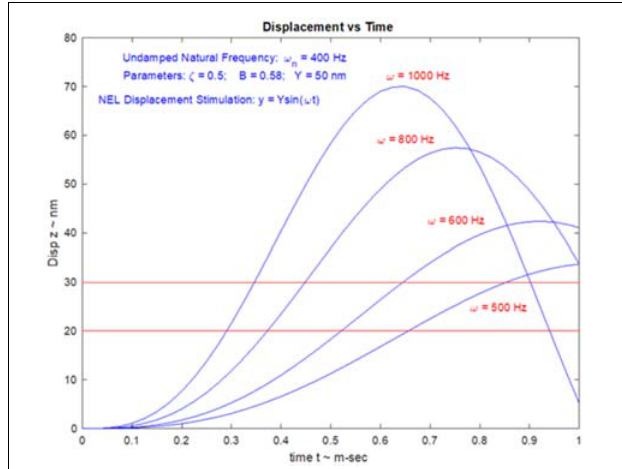
FIGURE 14 | Relative displacement z vs. time t , over 1 ms, for various stimulus frequencies. Suspected threshold range of 20–30 nm is shown in red (Grant and Curthoys, 2017). The two higher frequencies reach the threshold range before 0.5 ms, while the lower two reach this range in in a time frame greater than 0.5 ms. This figure shows a better illustration of the maximum or peak values for the transient behavior.